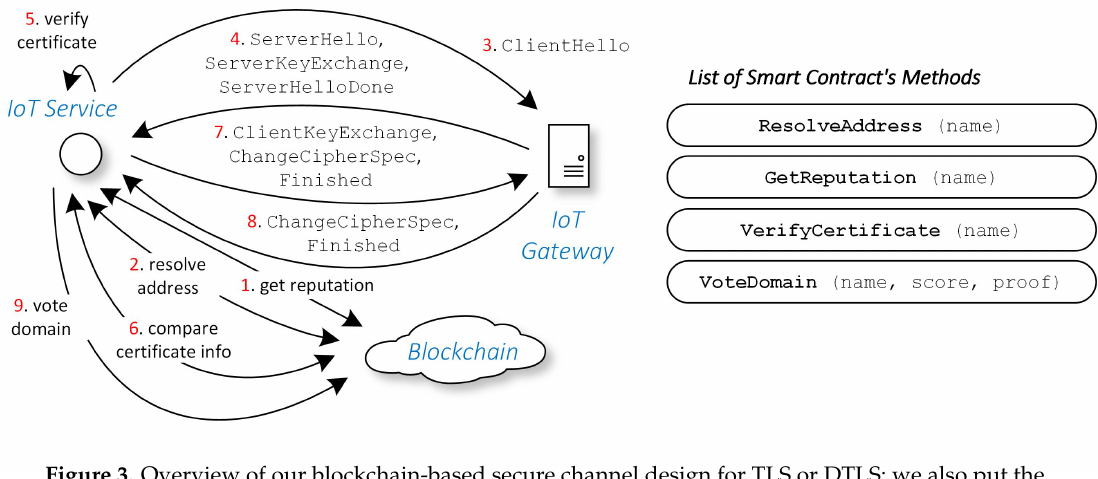
Figure 3. Overview of our blockchain-based secure channel design for TLS or DTLS: we also put the list of required smart contract methods for developers to